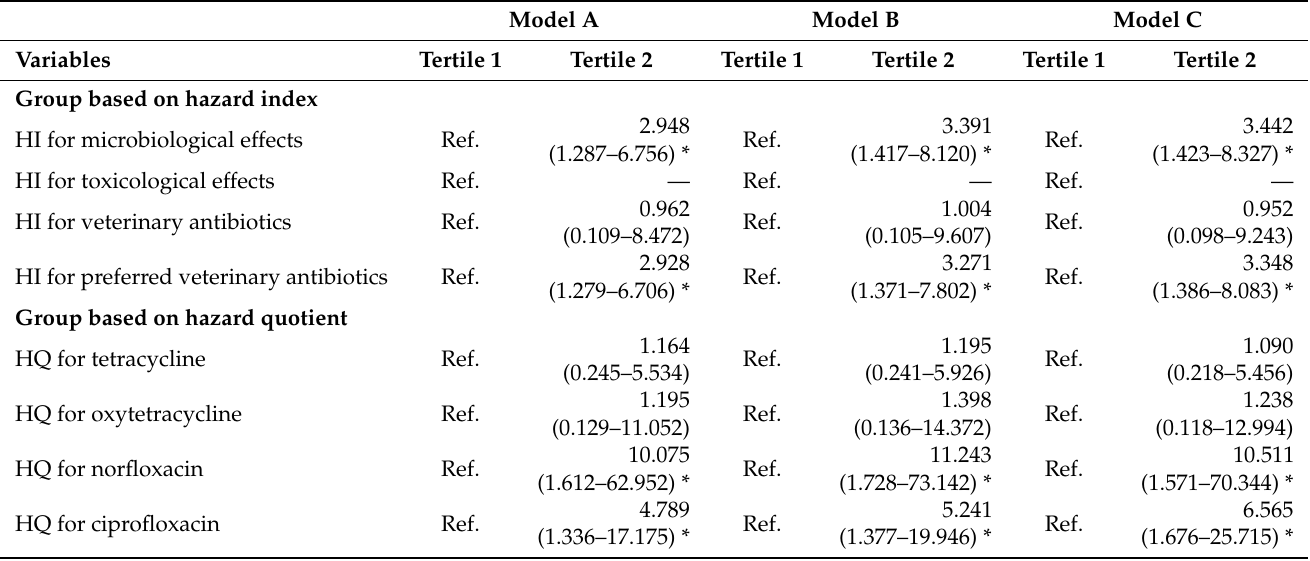
Table 5. Associations of urinary antibiotic risk index, risk quotient and diabetes risk in middle-aged and older people, on the basis of binary logistic